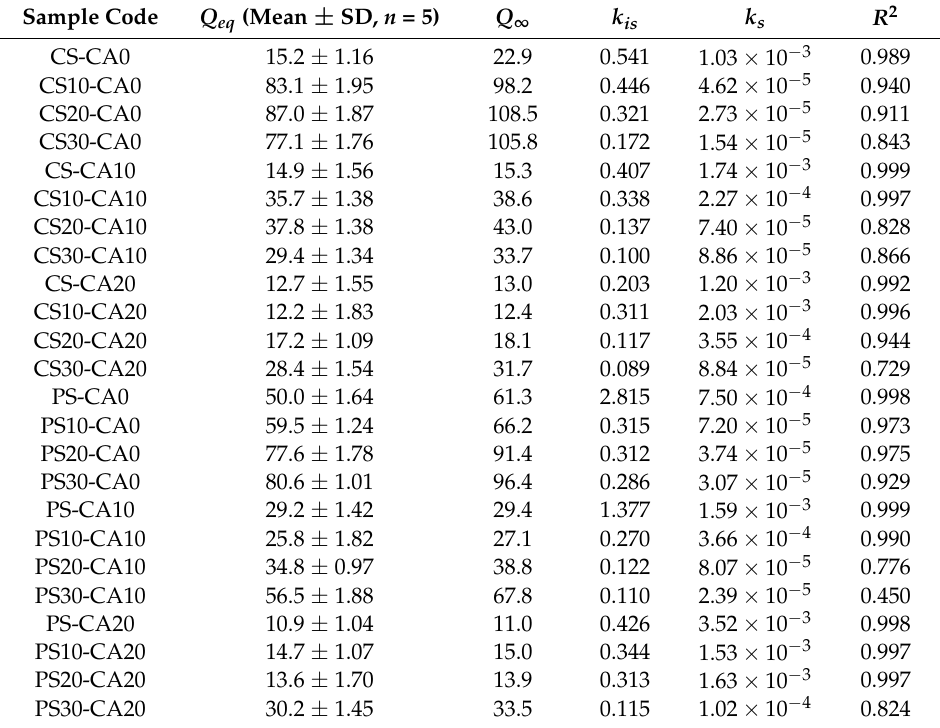
Table 5. The swelling parameters of polysaccharide-based SAPs in the Schott’s pseudo second order kinetics